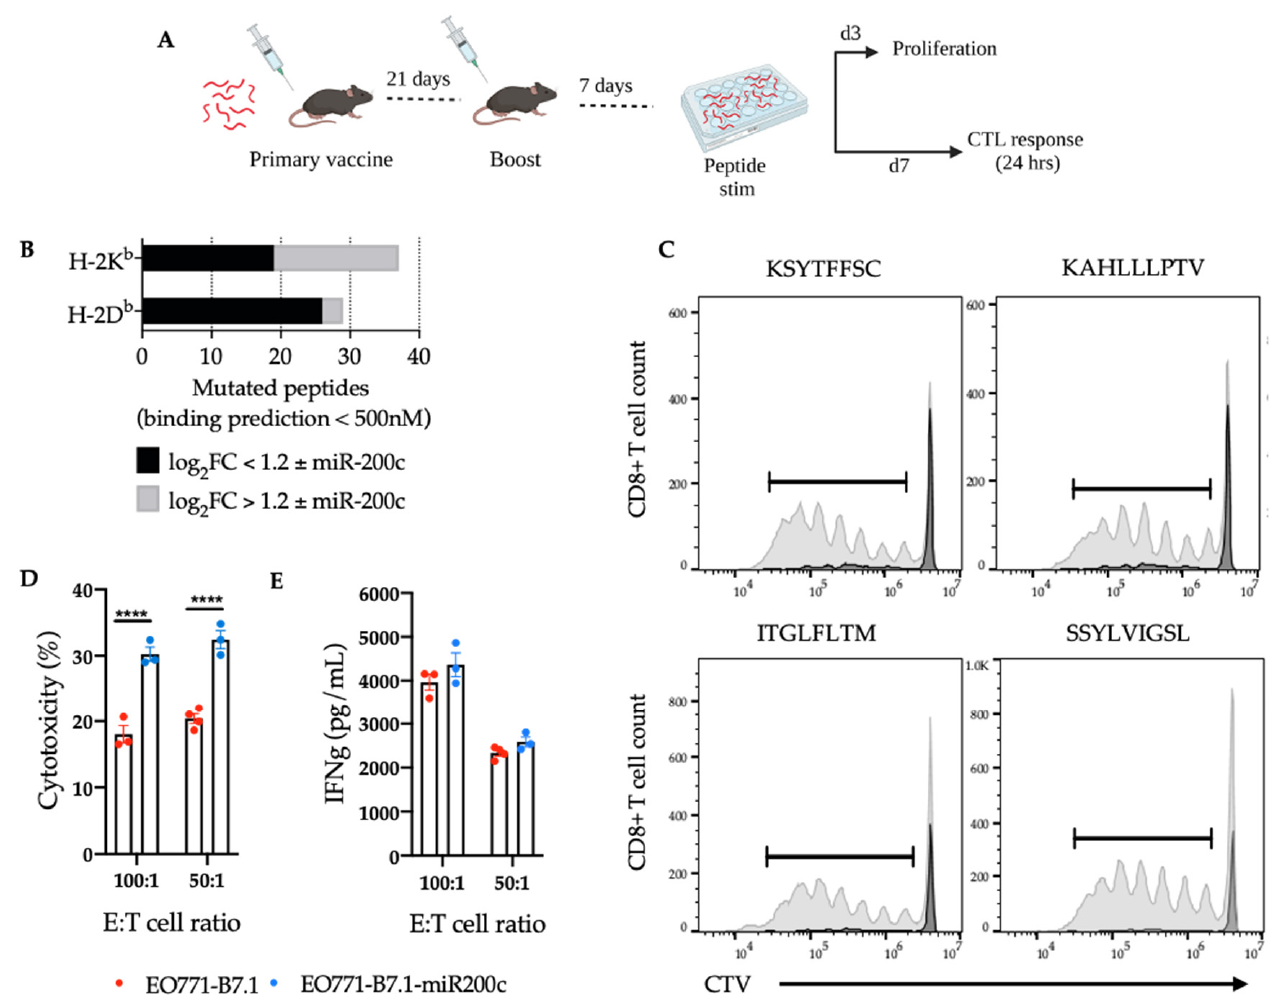
Figure 4. Restoration of miR-200c in EO771 alters expression of MHC class I SNV-derived neoantigens and putative SNV-derived peptides upregulated in mesenchymal-like EO771 cells elicit superior cytotoxic responses against epithelial-like EO771-miR-200c+ cells. ( A ) Overview of study design vac- cinating mice with pooled MHC class I peptides followed by ex vivo T cell assays. ( B ) Quantification of putative peptides resulting from somatic variants per H-2D b /H-2K b allele with strong binding affinity predictions (<500 nM) is shown. The gray bar fraction corresponds to the number of peptides with significant change in expression ± miR-200c. ( C ) Flow cytometry analysis depicting CD8 + T cell proliferation in response to stimulation with individual MHC class I SNV-derived peptides. The gray peaks represent the dilution of cell trace violet (CTV) stain as CD8 + T cells proliferate in response to specific peptide. The black peak represents CTV stain in non-proliferating CD8 + T cells treated with negative control (no peptide). ( D ) Quantification of percent cytotoxicity and ( E ) IFN γ measurements from splenocytes of mice vaccinated with pooled peptides expressed more in the mesenchymal conditions and challenged with EO771-B7.1 ± miR-200c target cells ex vivo at the respective Effector: Target cell ratio (E:T). A two-way ANOVA was performed using Sidak’s multiple comparisons and found significant differences in cytotoxicity against EO771-B7.1-miR-200c target cells at both E:T ratios ( p < 0.0001). The numerical p values listed in the figure legend correlate with the asterisks in the